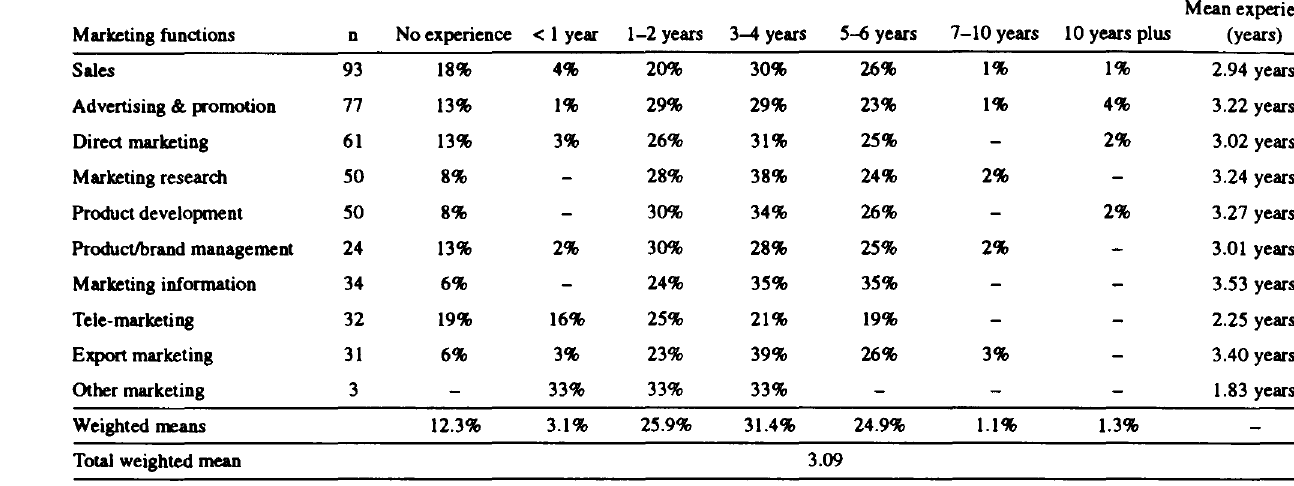
Table 6 Minimum level of wort< experience required per marketing function